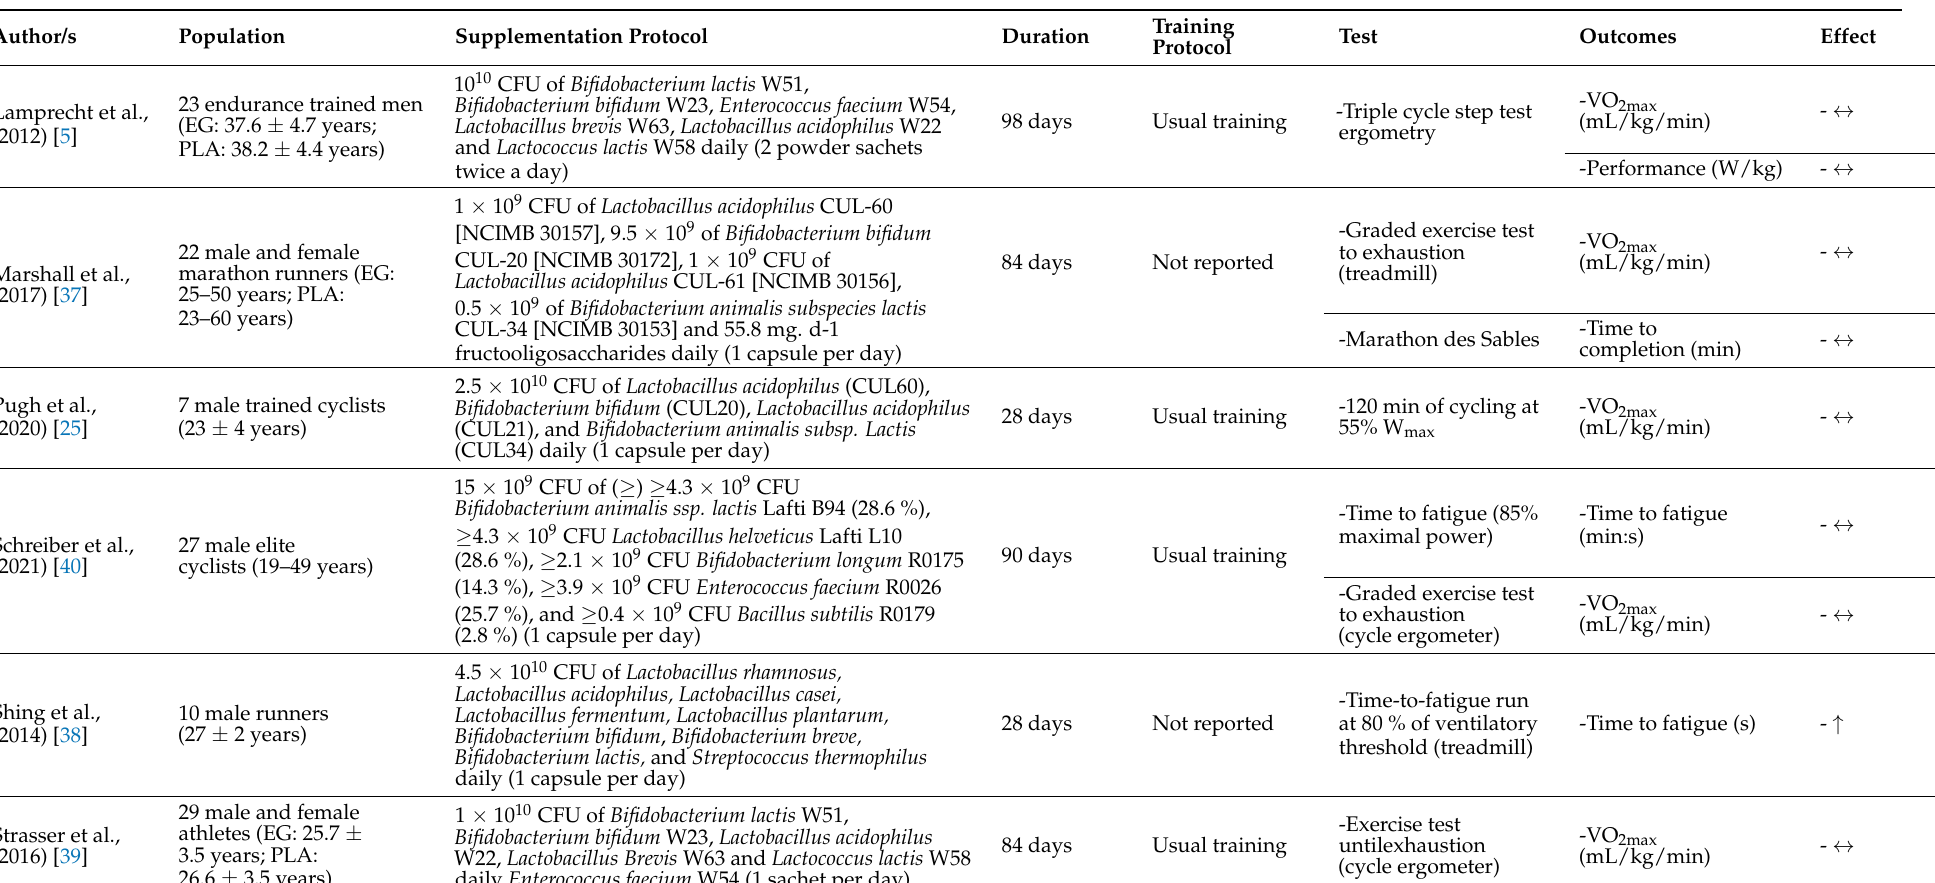
Table 4. Summary of the studies included in the systematic review that investigated the effect of multi strain probiotics on exercise in which the aerobic metabolism is predominant ( ≥ 5